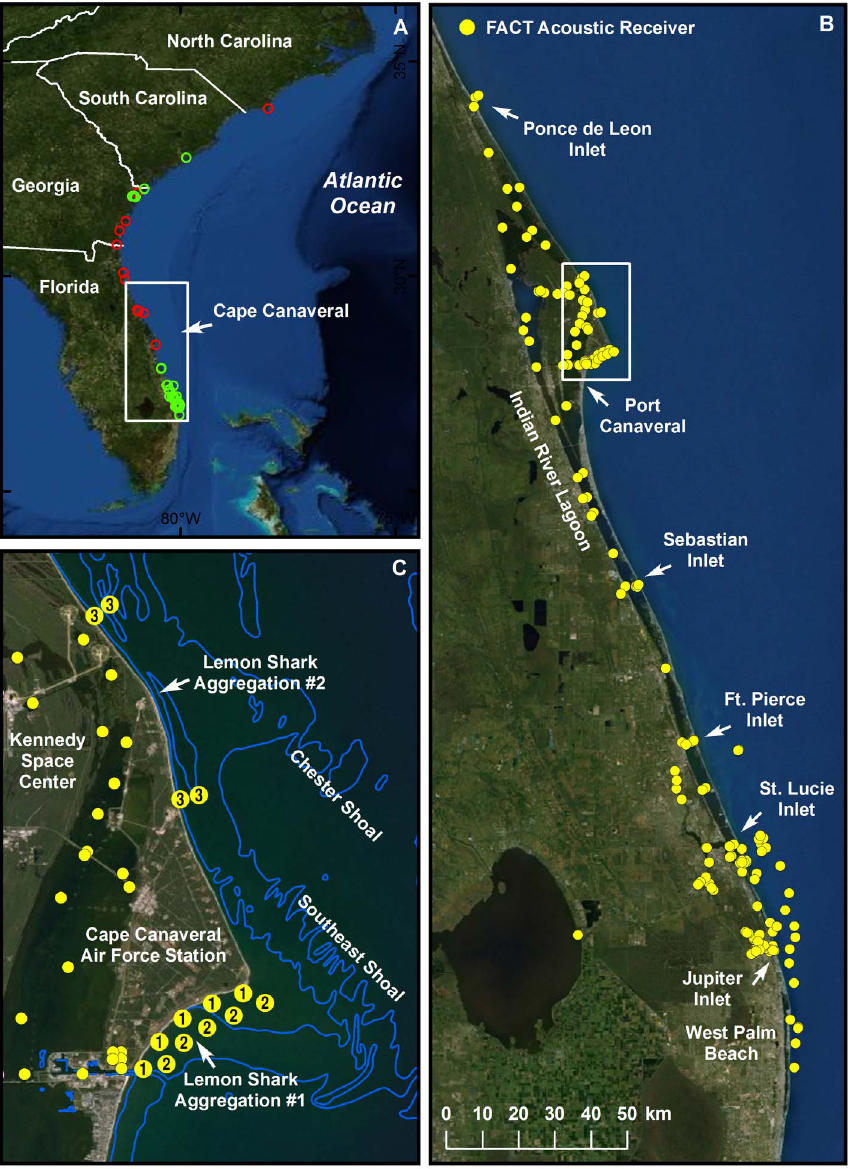
Figure 1. Passive acoustic tracking of lemon sharks in the US South Atlantic region. A) Overall study region including locations of all lemon shark acoustic detections (green circles) and historic angler recaptures (red circles) from sharks released at Cape Canaveral. B) Map of the